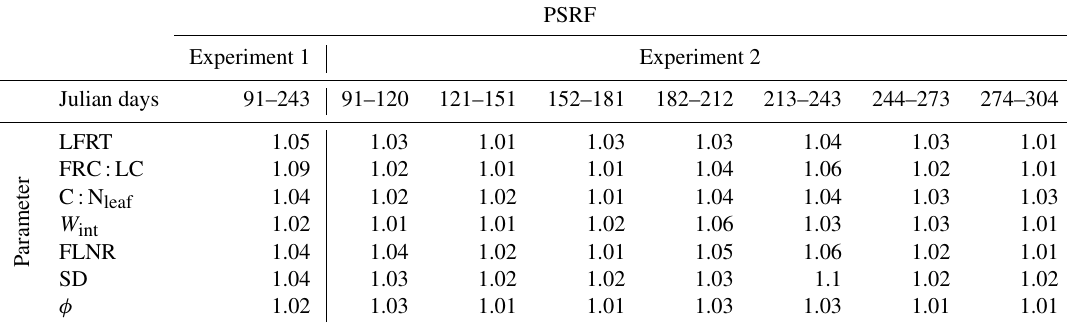
Table 2. Gelman–Rubin potential scale reduction factor (PSRF) of each Biome-BGC parameter selected for calibration and φ (nuisance parameter of likelihood function of Eq. 5) for Experiments 1 and 2. Information about the Biome-BGC parameters is given in Table 1. SD is the effective soil rooting